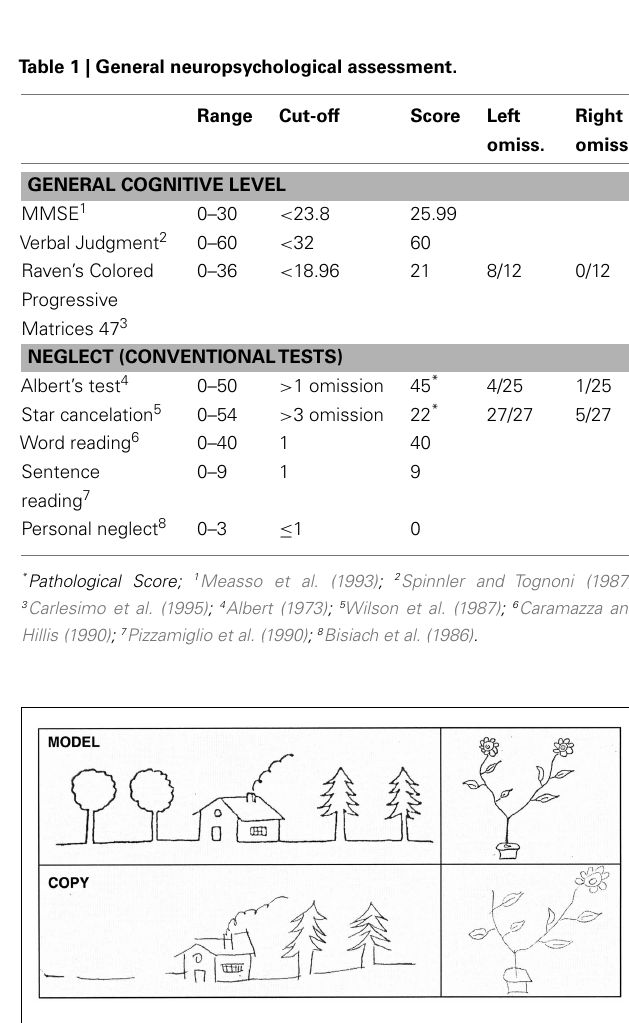
FIGURE 2 | Examples of patient’s copy of drawings . Upper part of the figure: original; lower part: patient’s copy. Note that some details are missing on the left side of the